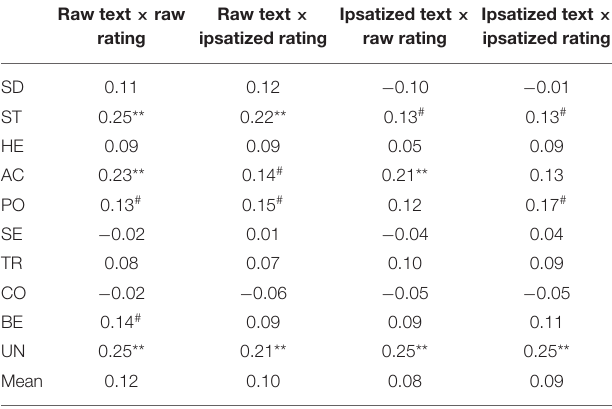
TABLE 6 | The correlations for motivationally matched value types in Study 2. Raw text × raw